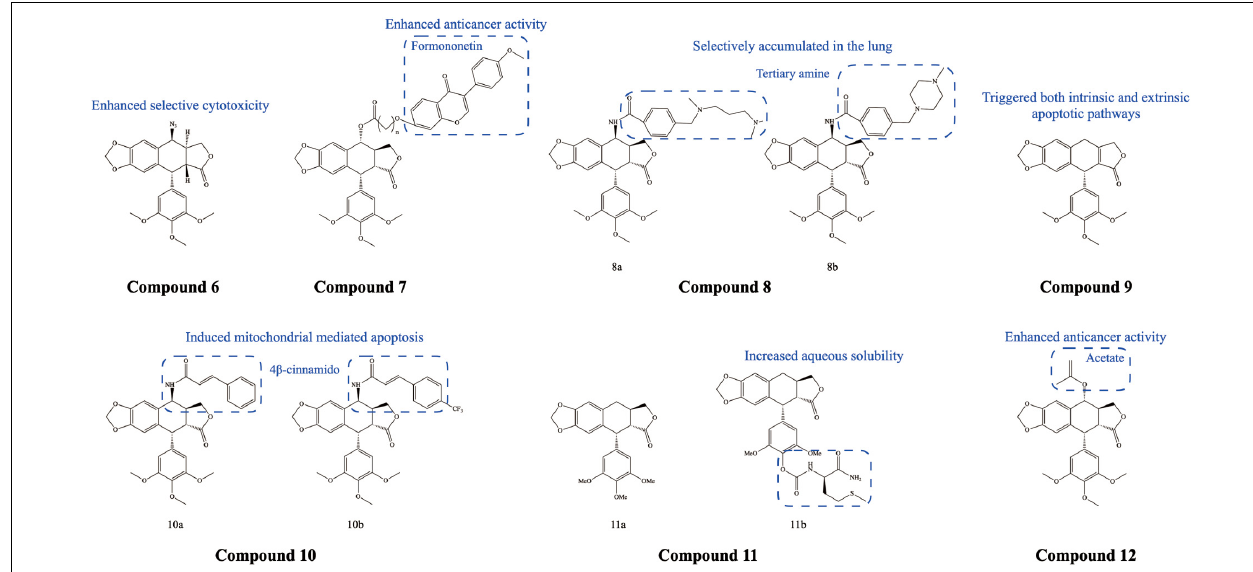
FIGURE 3 | Chemical structures and therapeutic highlights of PTOX derivatives Compound 6–12.